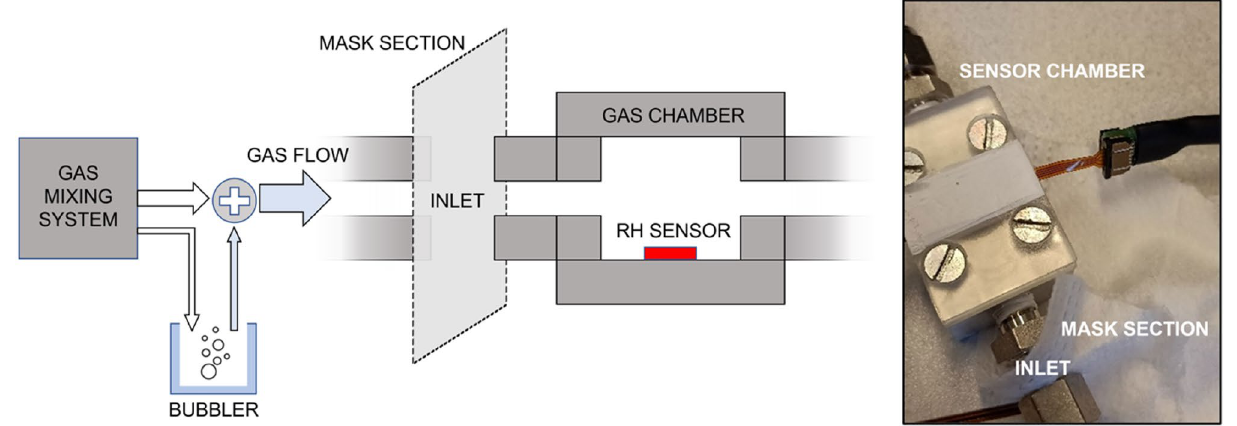
Figure 6. Relative humidity measurement setup scheme and picture of the gas test chamber with a face mask piece at the inlet, 3D-printed lid, and SHTC1 sensor during a measurement